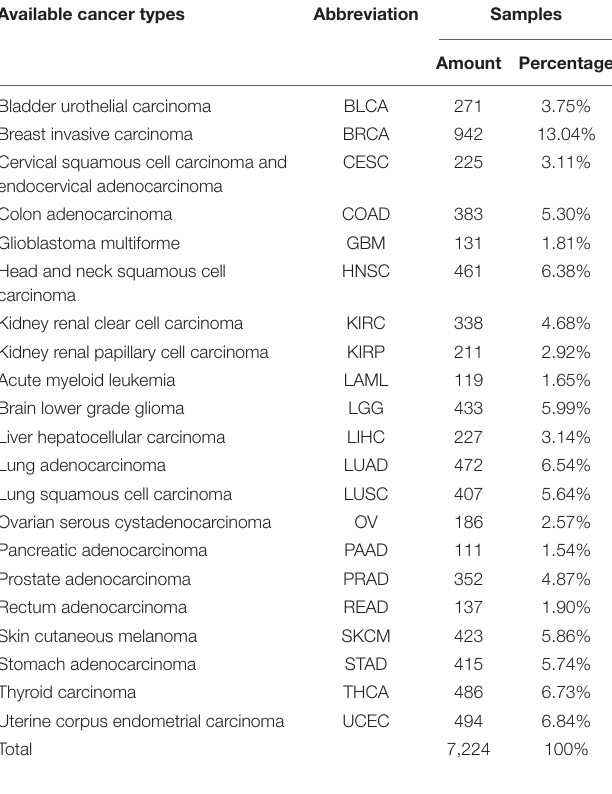
TABLE 1 | Sample information of each cancer from TCGA